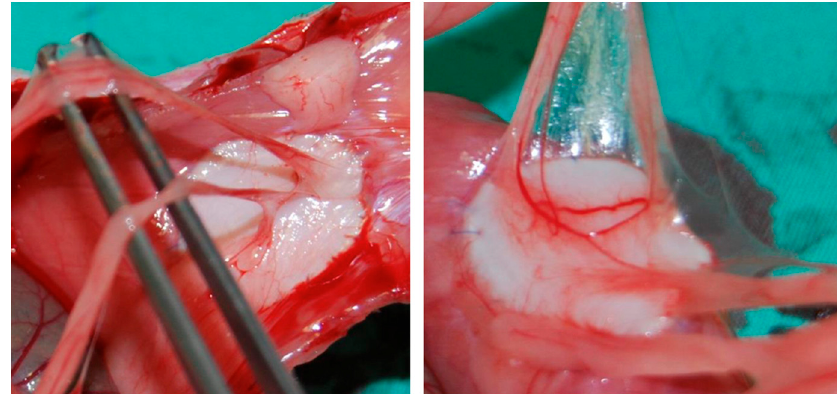
Figure 3 . (Partly extensive) adhesions after relaparotomy in the abdominal wall replacement model. Both Figures show different adhesions after the abdominal wall replacement.